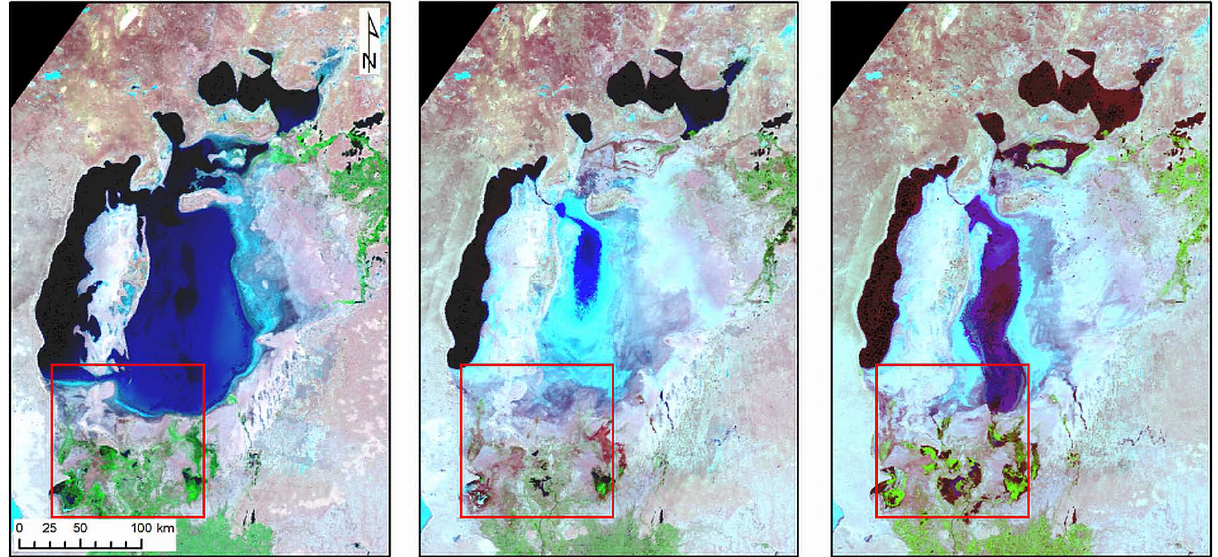
Fig. 2. Highly dynamic, spreading saline ecosystem: the Aralkum in Central Asia. Terra MODIS images acquired on July 2000, 2009 and 2010. Images displayed in false color band combination 7-2-1. Red squares indicate the study